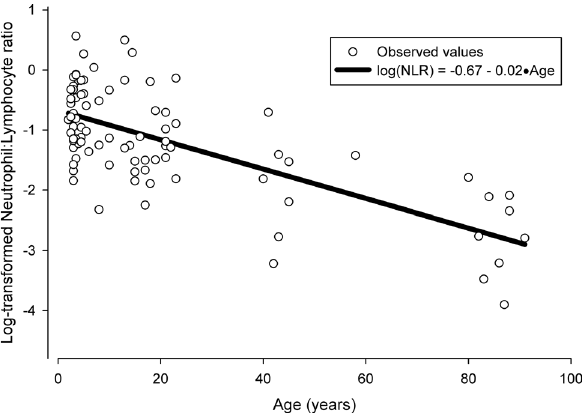
Figure 2. The relationship between age and log-transformed NLR in bigmouth buffalo ( Ictiobus cyprinellus ). NLR significantly decreased with age (F 1,86 = 78.26, p < 0.01, r 2 =